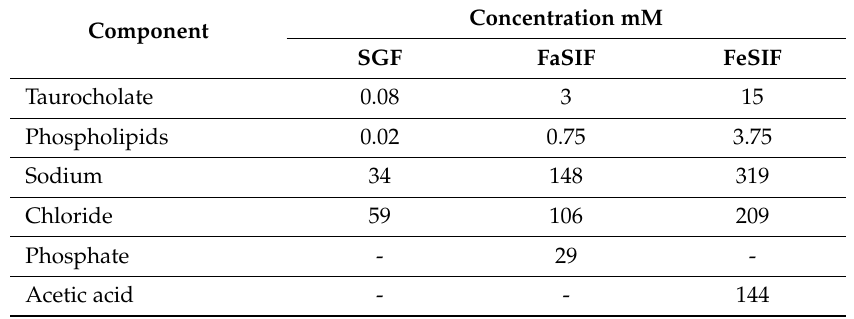
Table A1. Composition of biorelevant media as reported by manufacturer (Biorelevant